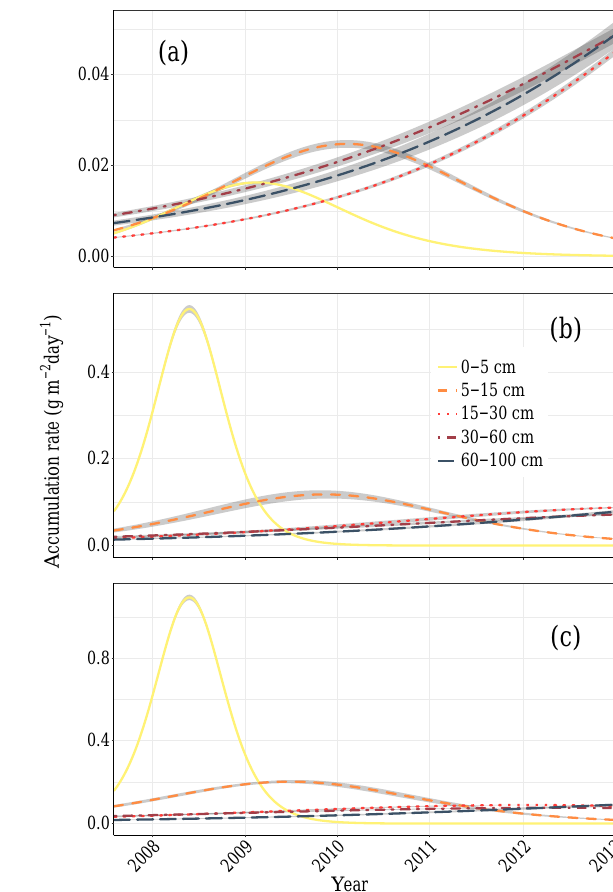
Figure 4. Modeled rates of root pool mass accumulation over 6 years in (a) continuous maize, (b) fertilized prairie, and (c) un- fertilized prairie at 0–5, 5–15, 15–30, 30–60, and 60–100cm. Grey shading represents 1 standard error of the mean. Different y axes are used to emphasize similarities and differences in timing and to make within-treatment relationships easier to see. Seasonal effects are smoothed.